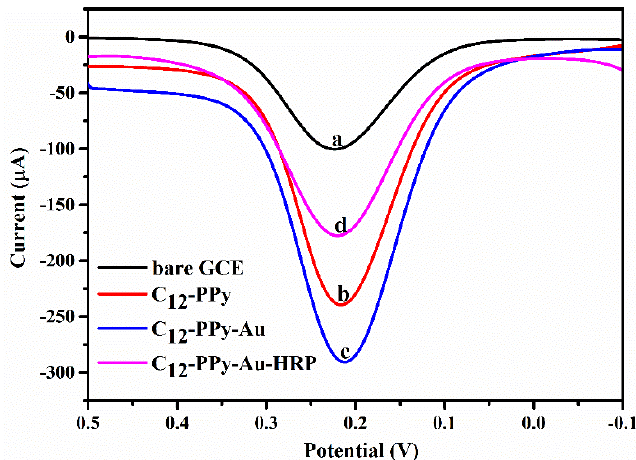
Figure 6. DPV current responses of stepwise modified GCE ( a ) bare GCE, ( b ) C 12 -PPy/GCE, ( c ) C 12 -PPy-Au/GCE and ( d ) C 12 -PPy-Au-HRP/GCE in 0.01 M PBS containing 5 mM Fe[(CN) 6 ] 3−/4− and 0.1 M KCl (pH 7.0).